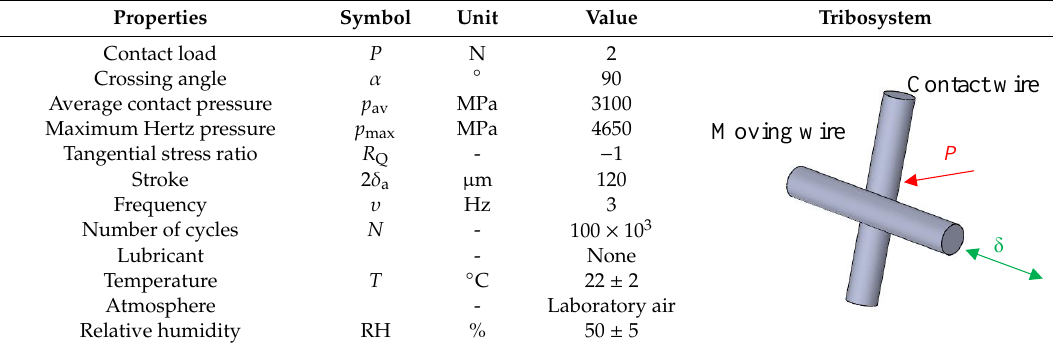
Table 1. Fretting tribological test conditions.